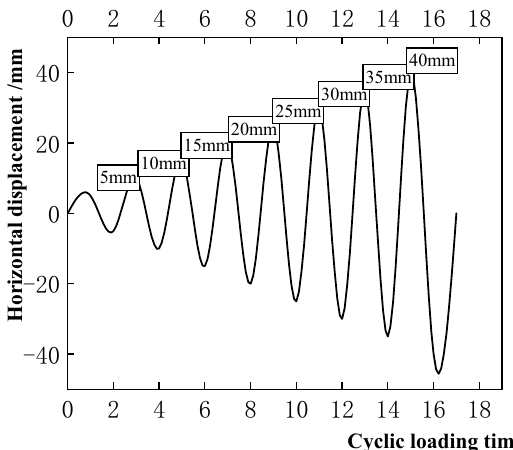
Figure 8. Displacement loading scheme.